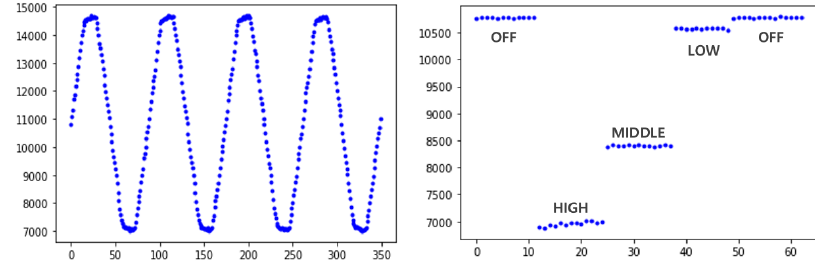
Figure 16. Current consumption of the heater.